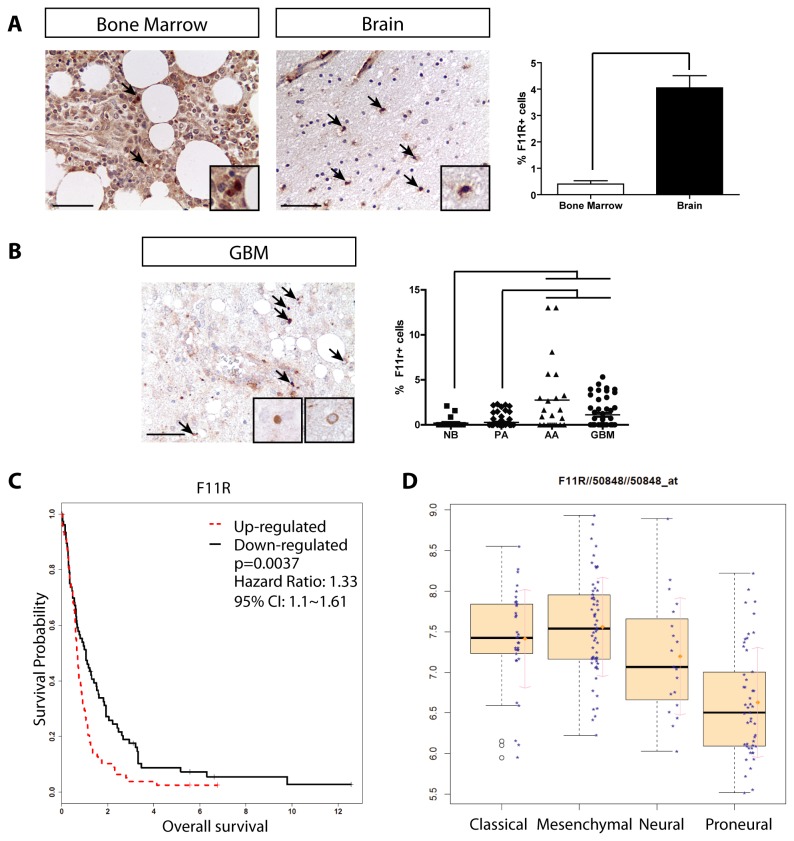
F11R expression correlates with GBM malignancy grade and survival.(A) Immunohistochemistry demonstrates that human bone marrow sections (n=3) have few F11R+ cells (arrows), while neurologically-normal post-mortem human frontal cortex brain sections contain numerous F11R+ mononuclear cells (n=3) (p= 0.0016). Endothelial cell labeling in the upper left quadrant of the brain section represent a positive control for staining. Scale bar = 50µm. Insets depict representative positively-labeled mononuclear cells. (B) A representative high-grade glioma, GBM, contains many F11R+ cells. Increased percentages of F11R+ cells (Kruskal-Wallis test/Dunn's Multiple Comparison Test, p<0.0001) are observed in high-grade glioma (AA, anaplastic astrocytoma, n=23; GBM, n=52) relative to low-grade tumors (PA, pilocytic astrocytoma, n=73) or normal brain (NB, n=23). (C) Kaplan-Meier curves and log rank test demonstrate that increased F11R expression negatively correlated with patient survival (GEO database: GSE16011, n=159, p=0.0037). (D) F11R was highly expressed in GSE16011 GBM samples assigned to Classical and Mesenchymal TCGA subtypes relative to the Proneural subtype (p=3.94E-12).